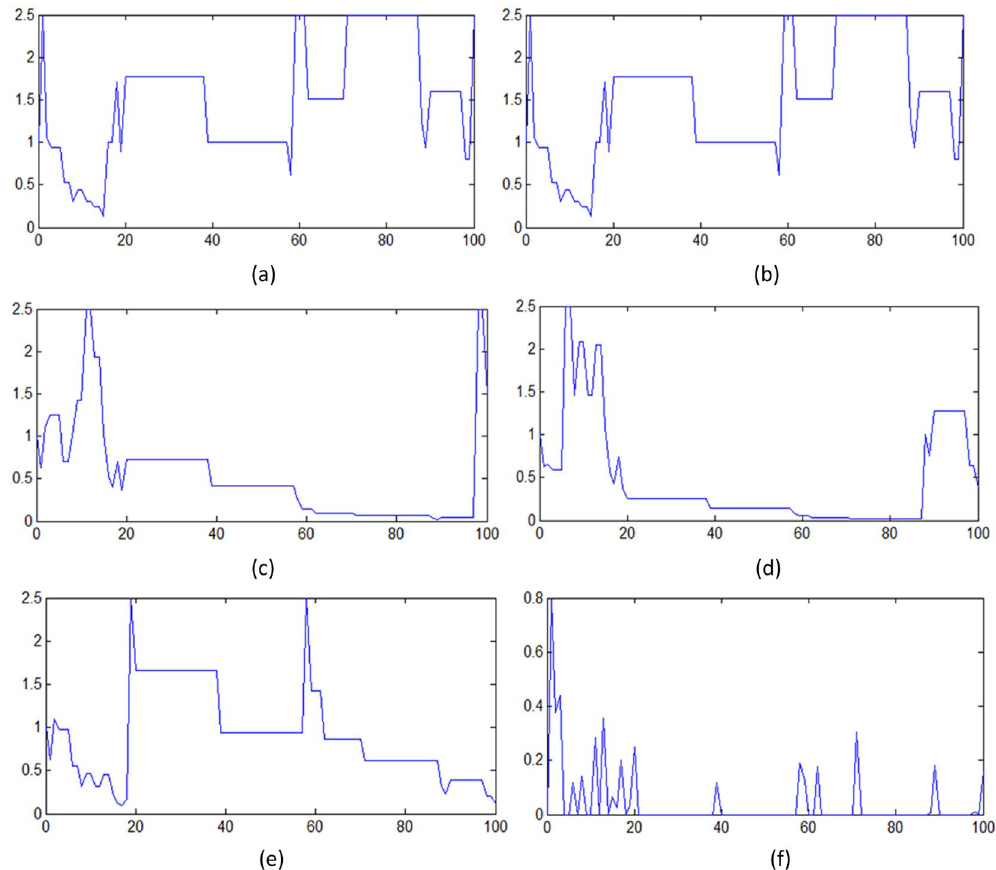
Figure 10. An example: variations of each wolf’s (weight × population) for a population of 5 within a maximum of 100 iterations in the sub-figures ( a–e ) and varations of living environments is showed in last sub- figure ( d ).